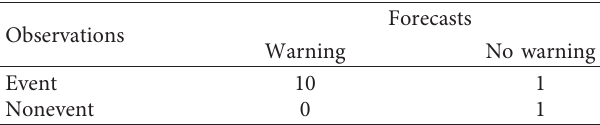
Figure 10: Rainfall, critical discharge (CQ), hydrographs observed ( Q Table 7: Statistics of warning results.